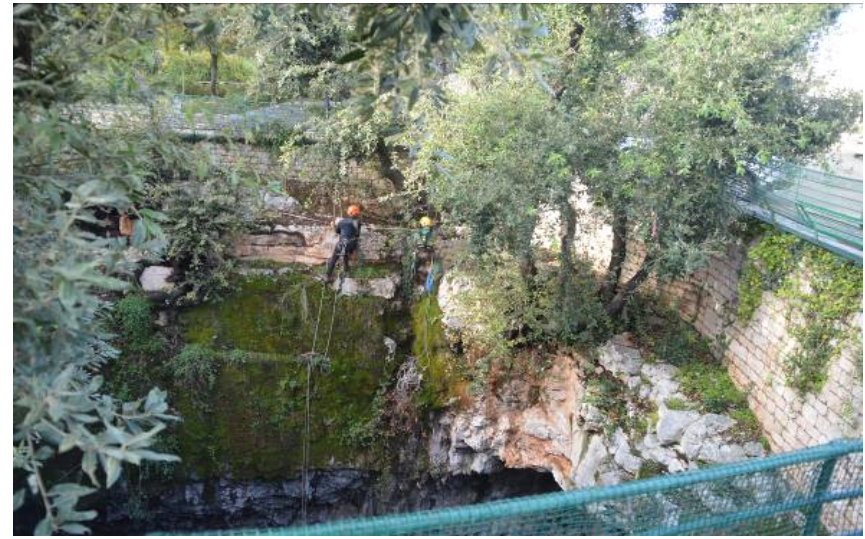
Figure 14. Acquisition phase of geo-mechanical data with standardized techniques (scanline by geologist rock climbers). Table 4. Average attitude of the discontinuity sets at the Grave entrance, identified by means of the classical geomechanical survey in rock walls.